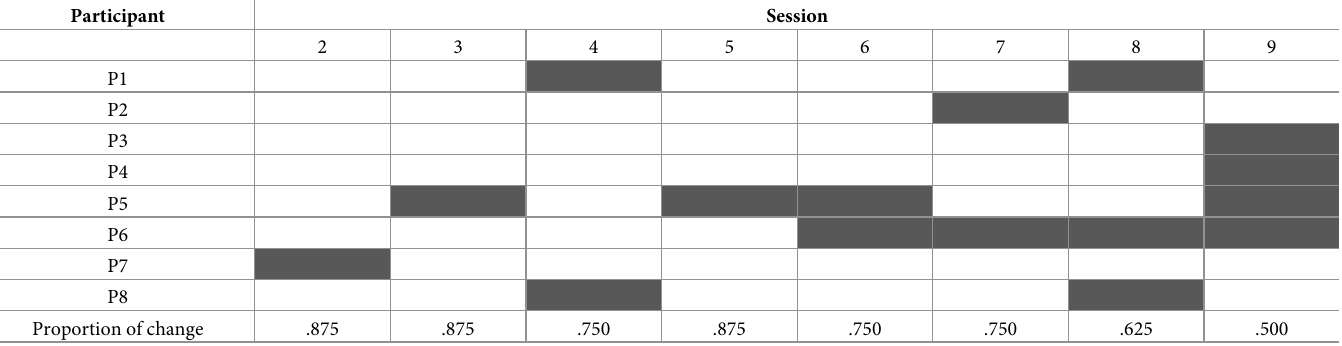
.750 .750 .625 .500 Grey frames show when participants chose to maintain the same route on the following session, whereas white frames display when they chose to practice on a new route. The proportion of change reflects the proportion of participants who chose to practice a new route on the following